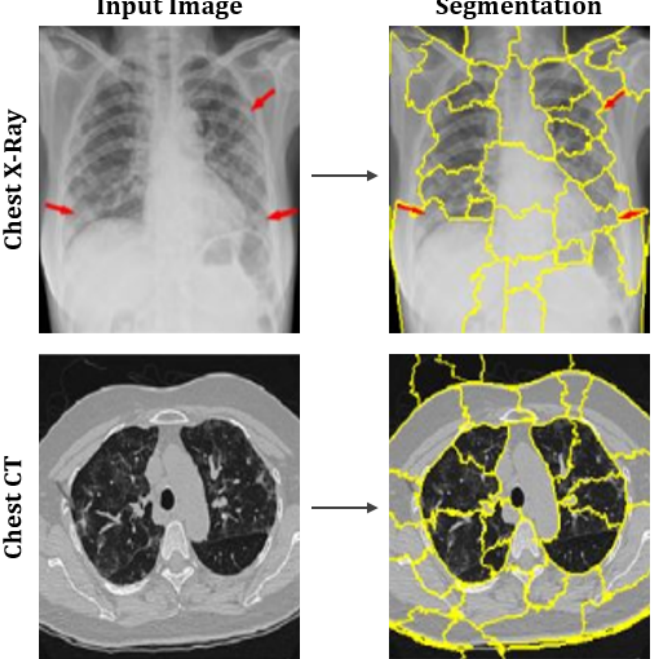
Figure 7. Representation of superpixels on sample images of chest X-rays and CT scans.